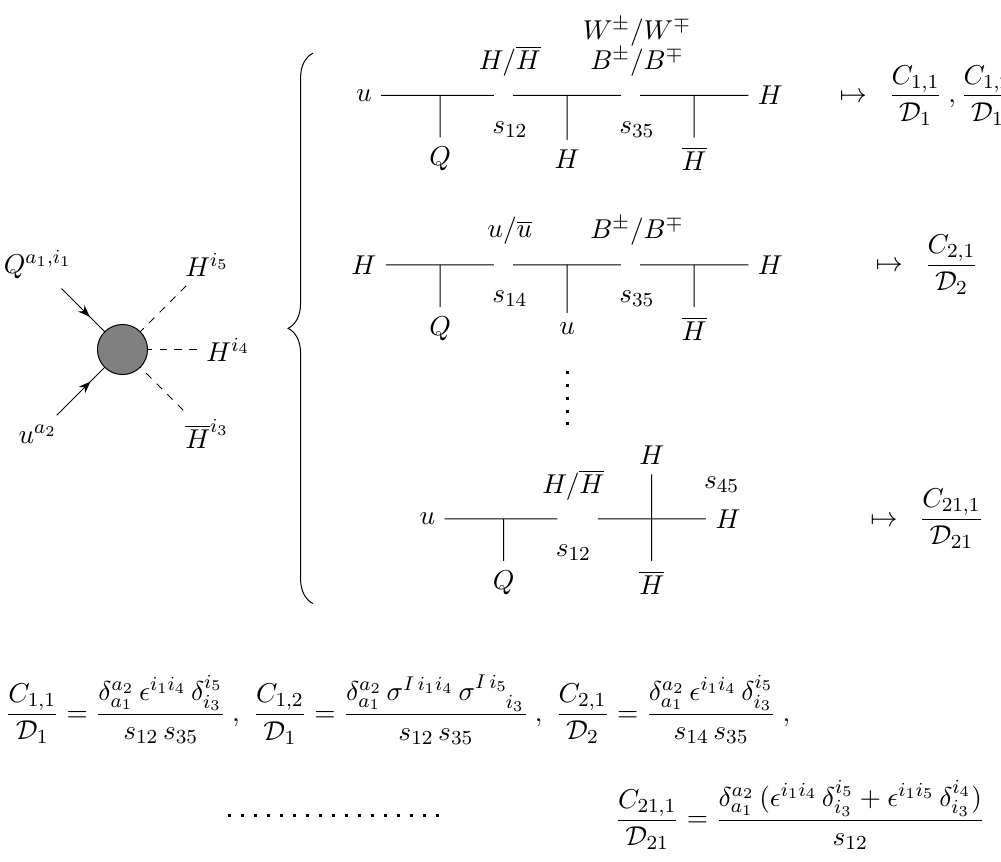
Figure 4 . The splitting of A 5 ( Q a 1 ,i 1 , u a 2 , H i 3 , H i 4 , H i 5 ) into trivalent graphs and the associated colour factors and kinematic denominators. There are a total of 21 possible trivalent graphs asso- ciated with this amplitude, we showed explicitly the first, the second and the last, as significant examples. The second is a trivial instance of trivalent graphs and there is a unique choice compat- ible with the Standard Model interactions of internal particle propagating. The same is not true for the first factorisation channel, for which we can have both B s and W s propagating, which give us two different colour structures C and C , respectively. The last channel is the only one for 1 , 1 2 , 1 this amplitude which involves an insertion of the quadrivalent Higgs